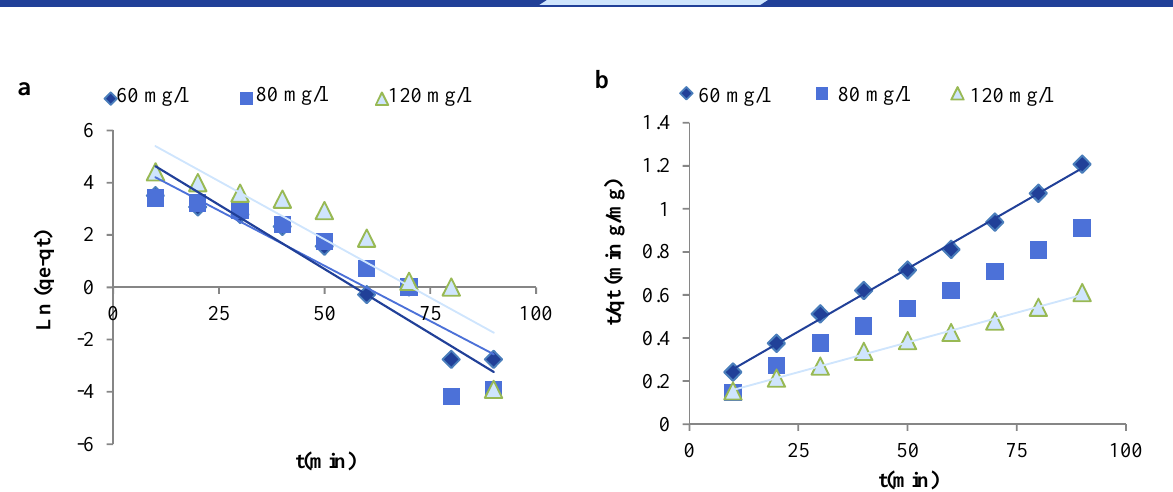
Figure 9. (a) Pseudo-first order and (b) pseudo-second order kinetics plots of Co(II) ions adsorption onto NiFe O nanoparticles 2 4 Table 3. Pseudo-first order and pseudo-second order kinetic model parameters for the adsorption of Co(II) ions onto NiFe O nanoparticles at 25 ºC 2 4 Pseudo-first order kinetic model Pseudo-second order kinetic C (mg/l) 0